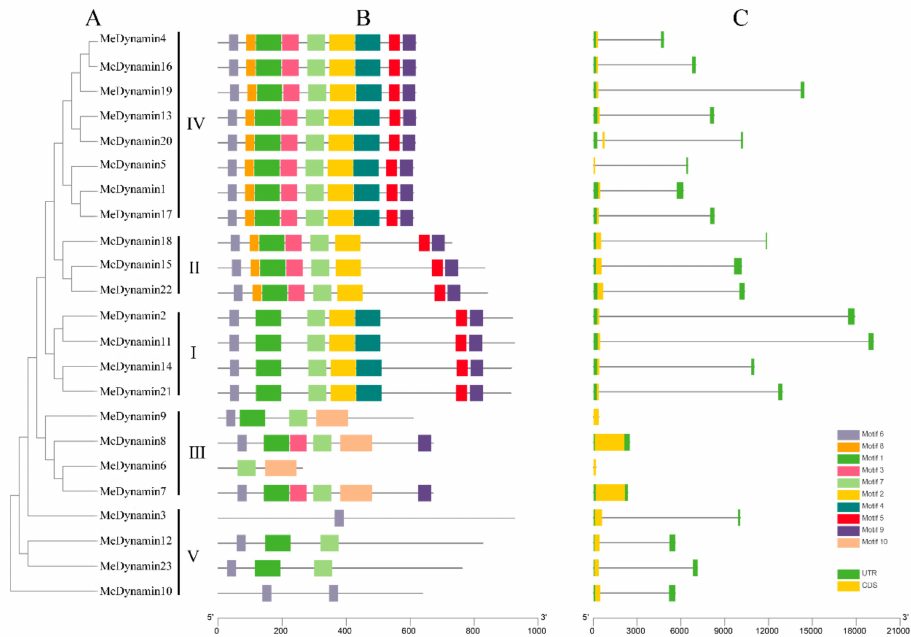
Figure 2. Phylogenetic relationships, gene structure and architecture of conserved protein motifs in Dynamin genes from cassava. ( A ) The phylogenetic tree was constructed based on the full-length sequences of cassava dyanmain proteins using MEGA 6 software. ( B ) The motif composition of cassava Dynamin proteins. The motifs, numbers 1–10, are displayed in di ff erent colored boxes. The sequence information for each motif is provided in Supplementary Table S4. ( C ) Exon-intron structure of MeDynamins . Red boxes indicate untranslated 5 (cid:48) - and 3 (cid:48) -regions; yellow boxes indicate CDS (Coding sequences); black lines indicate introns. The length of protein can be estimated while using the scale at the